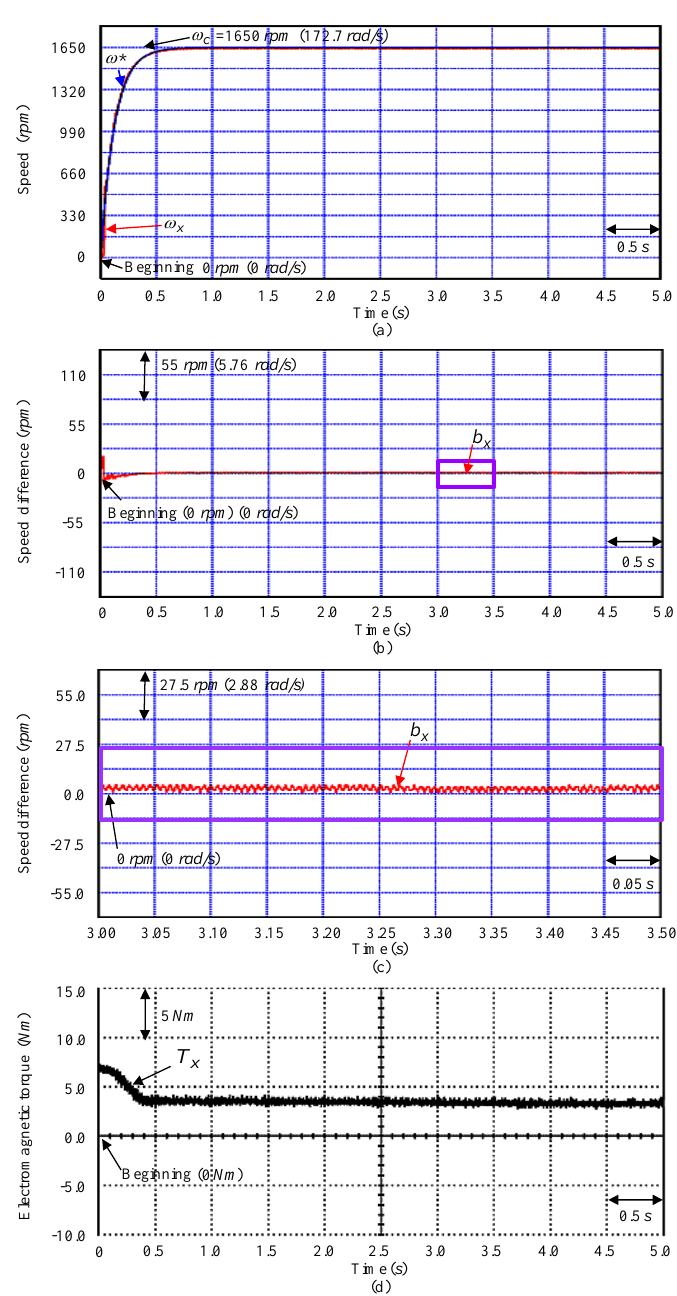
Figure 10. Tested instances with experimental results obtained by using the controller CD3 for the SSCCRIM impelled continuously variable transmission assembled system obtained at the examination Y1 instance: ( a ) speed response, ( b ) speed difference response, ( c ) enlargement of speed difference response, ( d ) electromagnetic torque response .